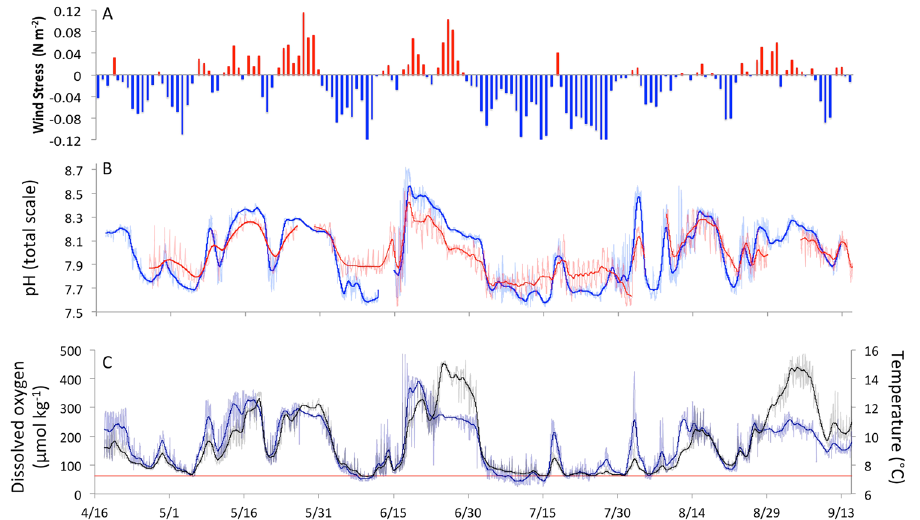
Figure 3. ( a ) 2013 wind forcing as indexed by along-shore wind stress at 44.65N, ( b ) intertidal pH (red) and inner-shelf pH (blue) at 44.25°N, ( c ) temperature (black) and dissolved oxygen (blue) from moorings deployed directly offshore (15 m water depth). Red line in ( c ) denotes hypoxia threshold of 65 μ mol kg − 1 . Bold lines in ( b , c ) denote low-pass filtered (40 h window LOESS filter)